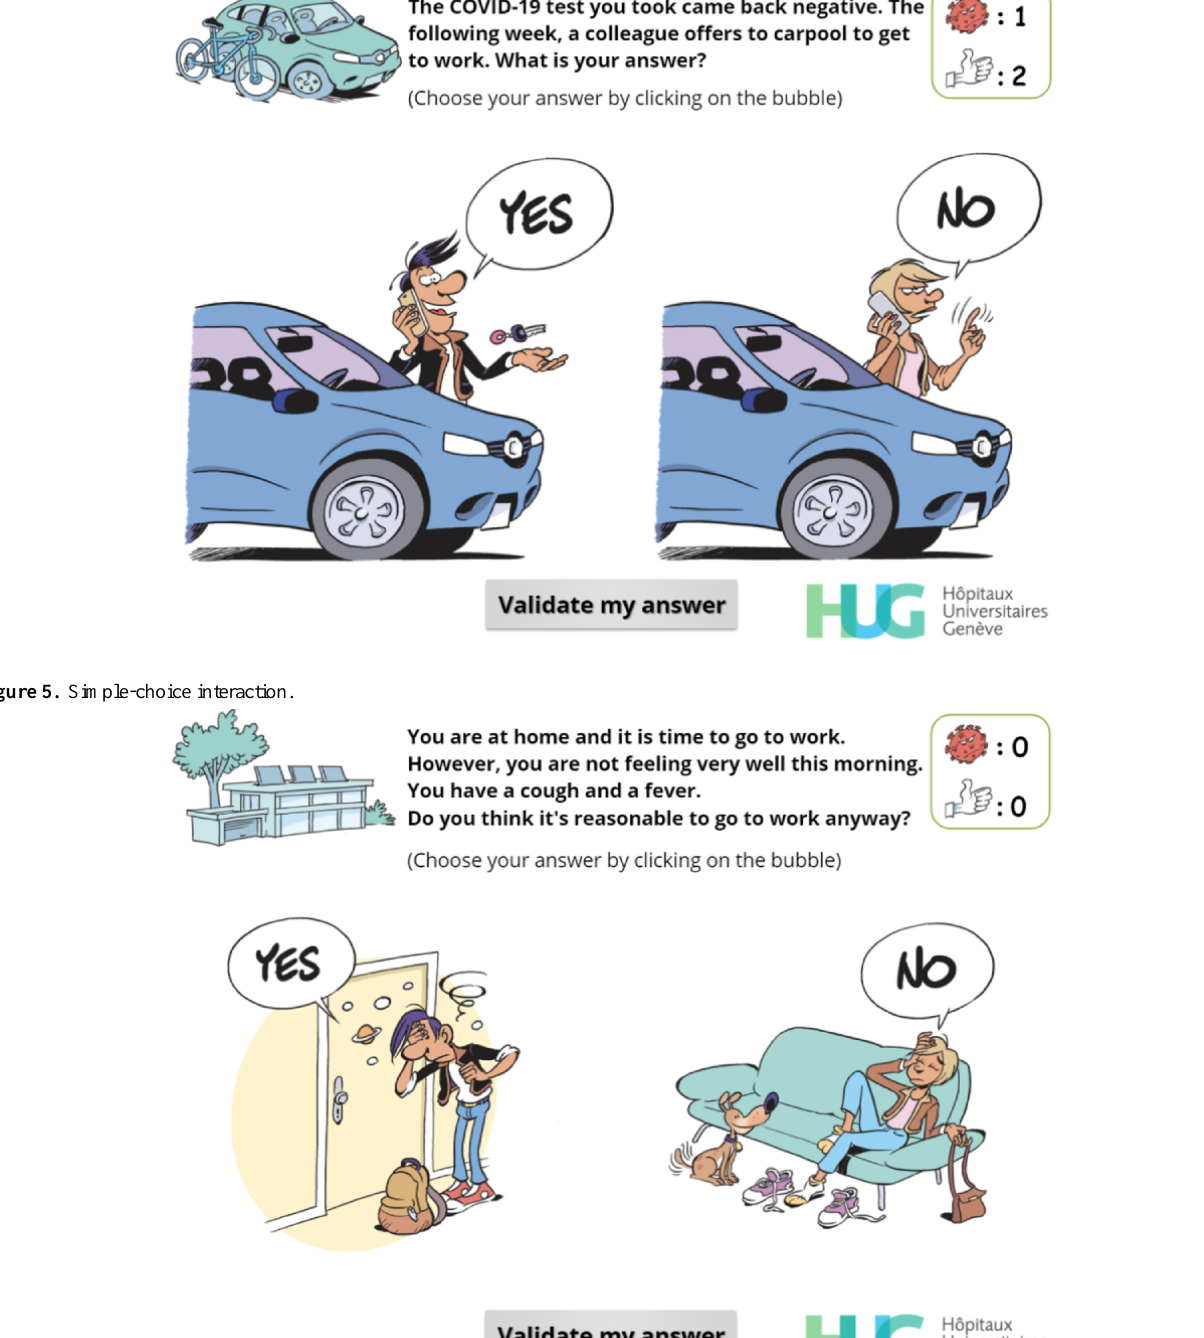
Figure 4. Final version of a simple-choice interaction.